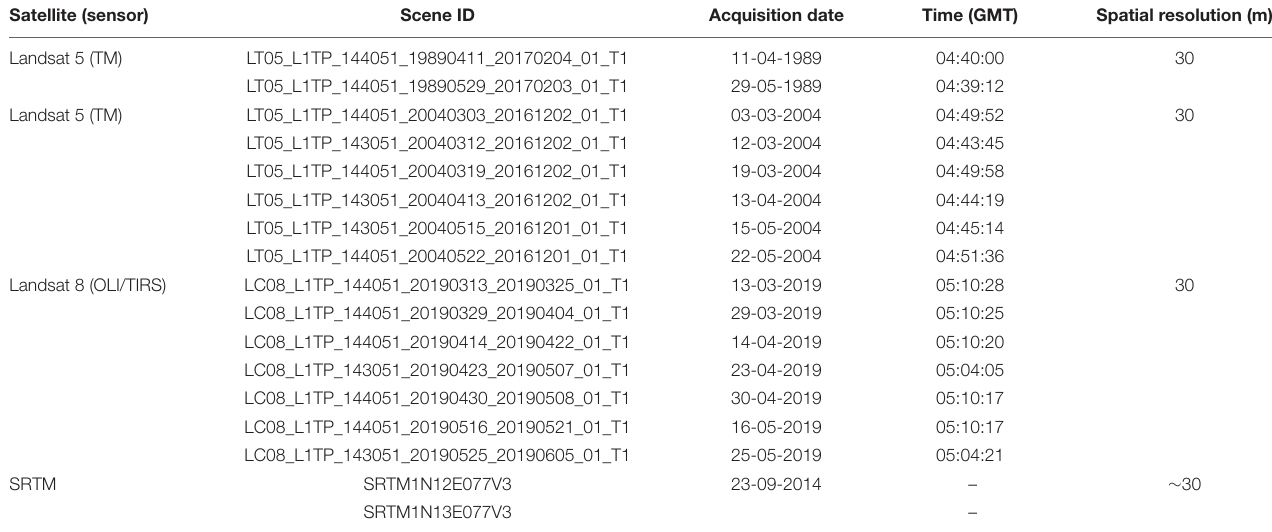
TABLE 1 | Description of the Landsat datasets for the study area. Satellite